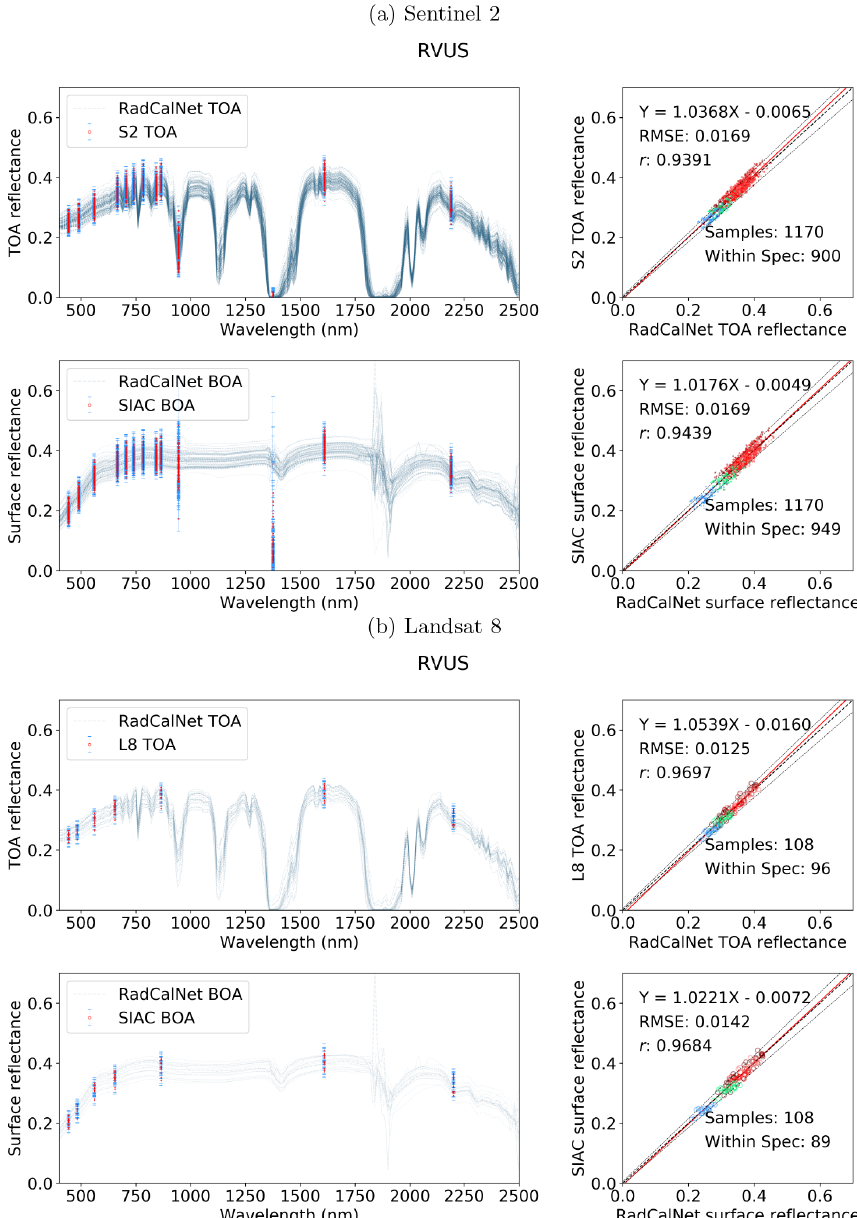
Figure 13. Same as Fig. 11 but for Railroad Valley Playa